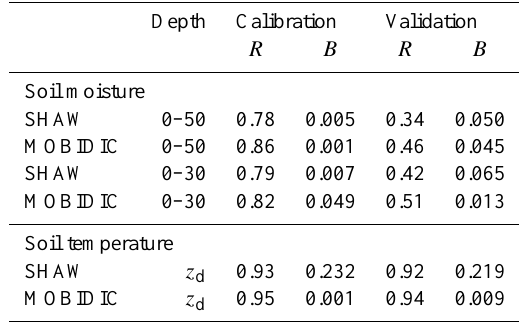
Table 5. Performance of the SHAW and MOBIDIC models of Site 2 for the calibration period (water years 2006 and 2007) and valida- tion period (water year